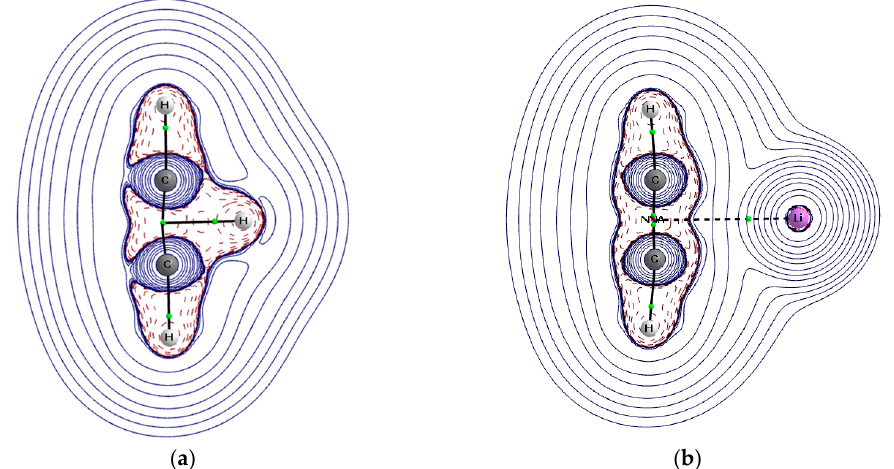
Figure 3. The contours of the Laplacian of electron density, ∇ 2 ρ , for the ( a ) C 2 H 3+ cation and ( b ) C 2 H 2 Li + cation. Continuous lines correspond to the positive values of ∇ 2 ρ , while broken lines correspond to negative